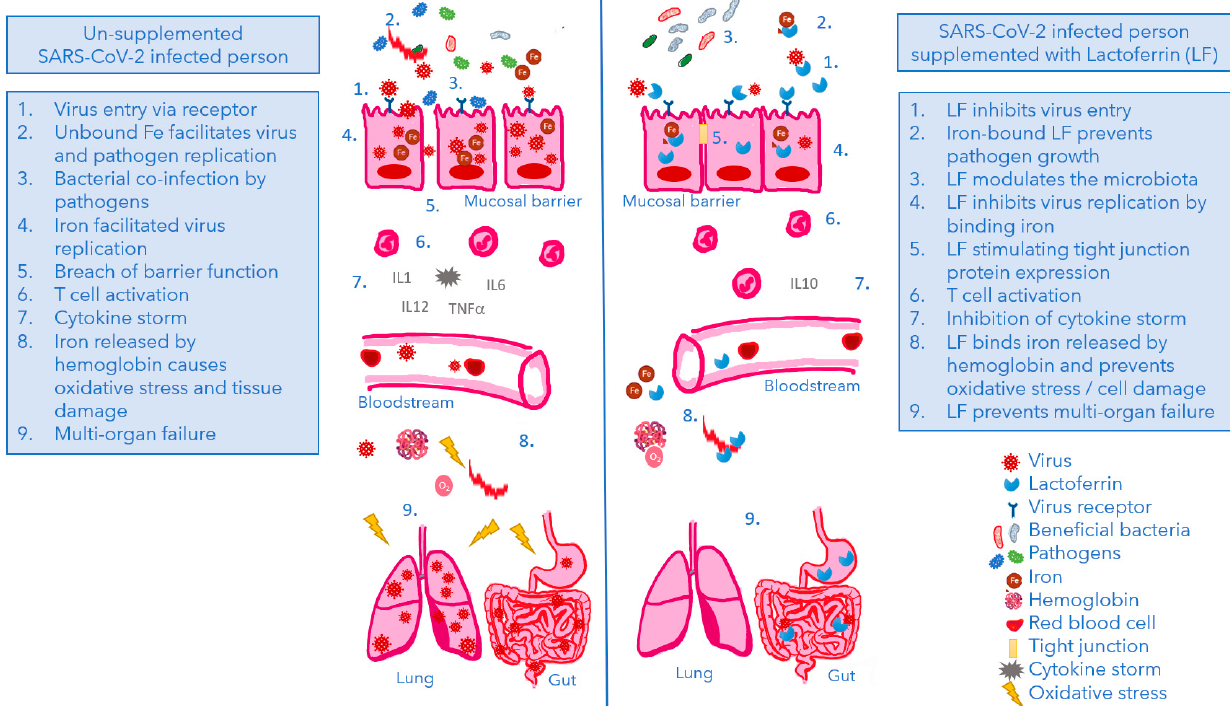
Figure 3. Model illustrating the different stages of a SARS-CoV-2 infection in un-supplemented (left panel) and in LF-supplemented (right panel) COVID-19 patients. Based on the here presented data, LF protects the host from viral infections by prevention of binding and entry of SARS-CoV-2, and sequestering iron needed for viral replication. Furthermore, it indirectly affects virus attacks by having anti-oxidant effects and immune-, microbiome-, and intestinal barrier-modulatory characteris- tics.